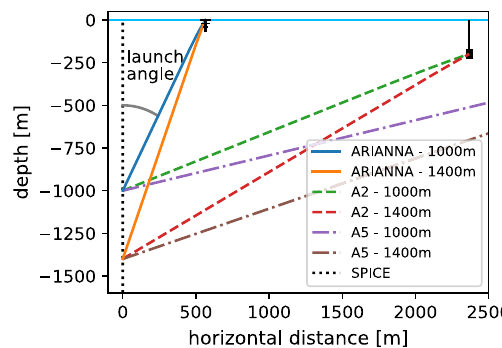
Fig. 6 Side view of two radio signals propagating from the transmitter in the SPICE hole at − 1000m and − 1400m depth to the antennas of the ARA and ARIANNA stations. Detector station ARA5 is outside of the plot range but the signal trajectories are